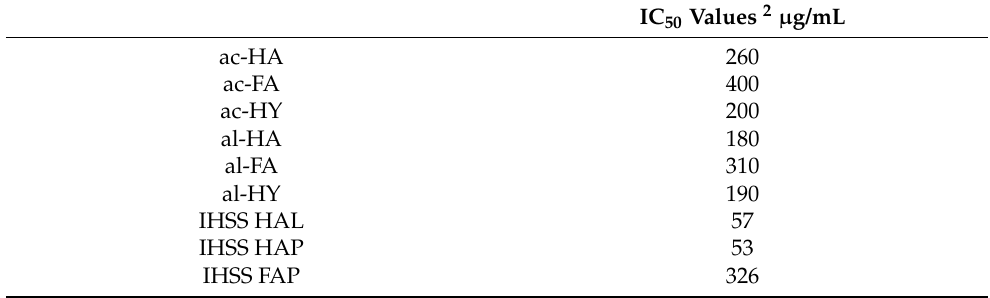
Table 4. DPPH free radical scavenging activity of different HS fractions expressed as IC 50